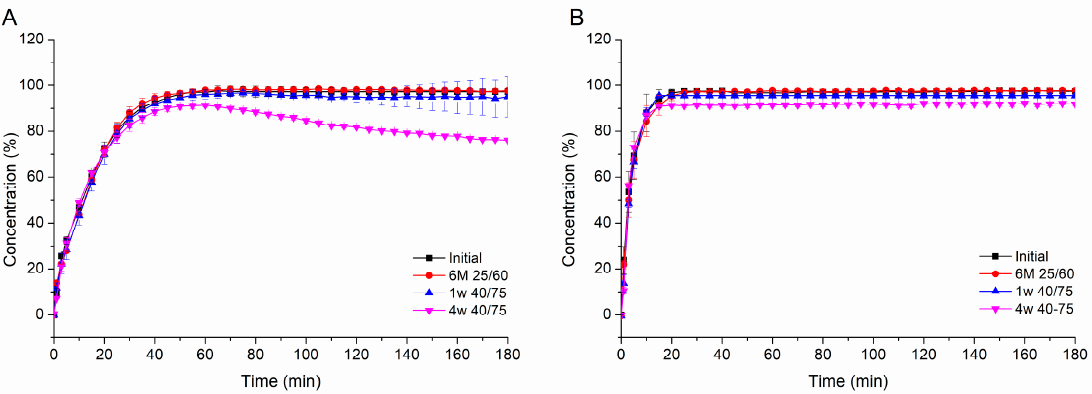
Figure 10. Non-sink dissolution of IND-PVAP ASDs upon storage at di ff erent conditions at pH 5.5 ( A ) and pH 6.8 ( B